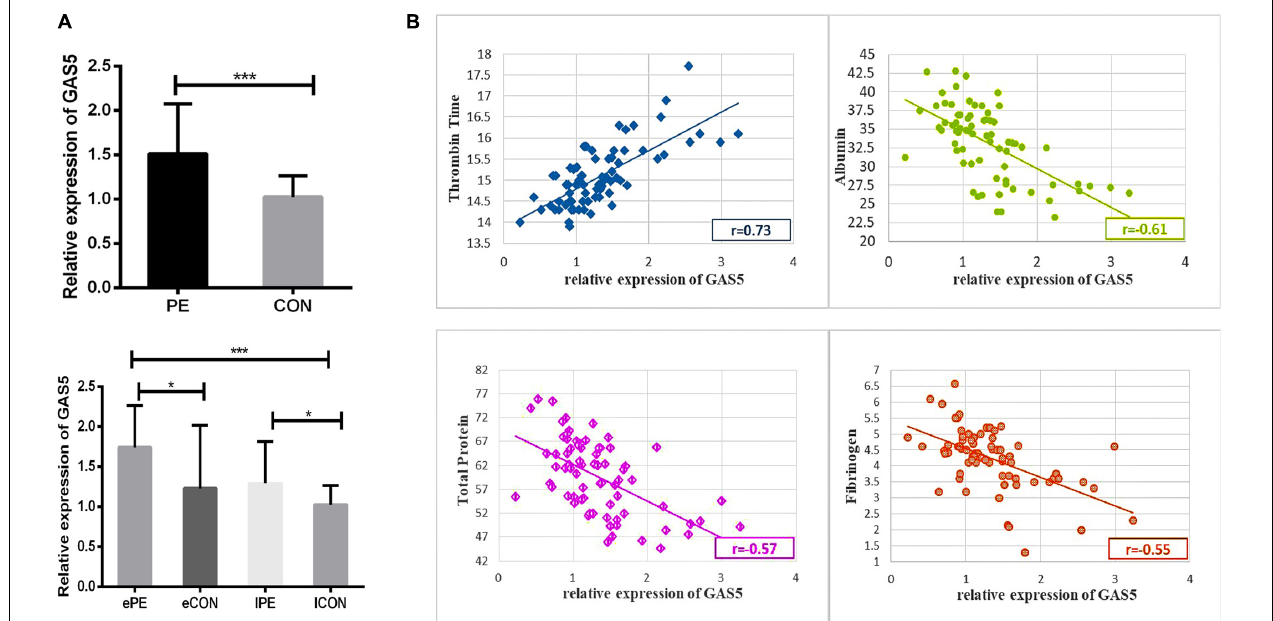
FIGURE 1 | (A) The histogram showed the expression of GAS5 elevated in PE groups. The expression level of GAS5 was significantly higher in ePE compared to lCON and eCON. Respectively, the level of GAS5 was also significantly higher in lPE compared to lCON. (B) Scatter diagram showing correlation between GAS5 expression level and clinical parameters including TT, Albumin, Serum total protein and Fibrinogen. * P < 0.05, ** P < 0.01, *** P <